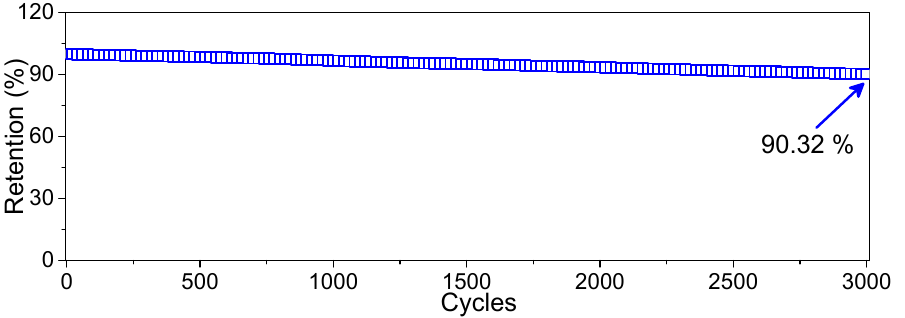
Figure 9. Capacitance retention vs. cycles number over 3000 cycles.